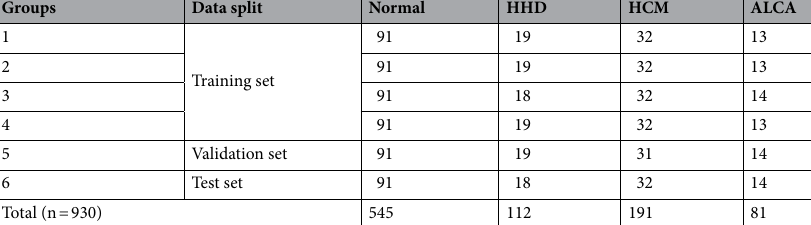
Table 2. Splitting of the data into training, validation and test sets. Total study population was split into 6 groups, of which 4 groups were designated as the training set, and remaining 2 groups designated as the validation and test sets, respectively. AF atrial fibrillation, BMI body-mass index, ALCA light-chain cardiac amyloidosis, EDD end-diastolic dimension, EDV end-diastolic volume, EF ejection fraction, ESD end-systolic dimension, ESV end-systolic volume, HHD hypertensive heart disease, HCM hypertrophic cardiomyopathy, IVSd interventricular septum at end-diastole, LVPWd left ventricular posterior wall thickness at end-diastole, LVWTmax end-diastolic maximal LV wall thickness, LA left atrium, LAVI left atrial volume index, LV left ventricular, MI mass index, N/A not applicable, PASP pulmonary artery systolic pressure, TR tricuspid